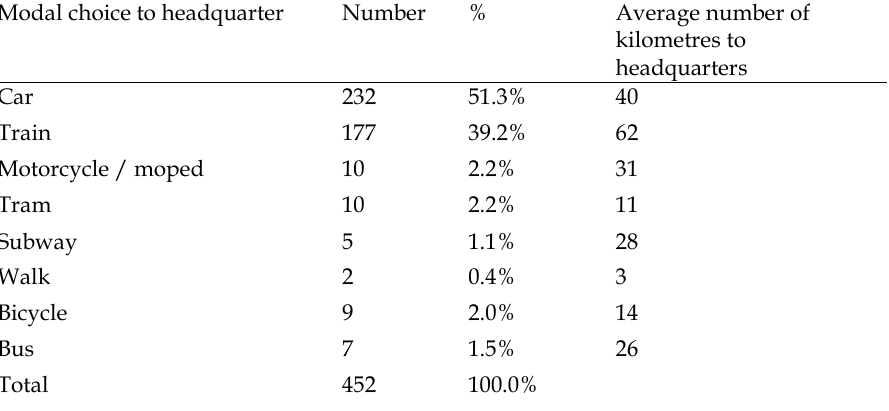
Table 5. Modal choice, number of respondents (total and percentage) and average number of vehicle kilometres with main mode of transport for commuting to HQ by home